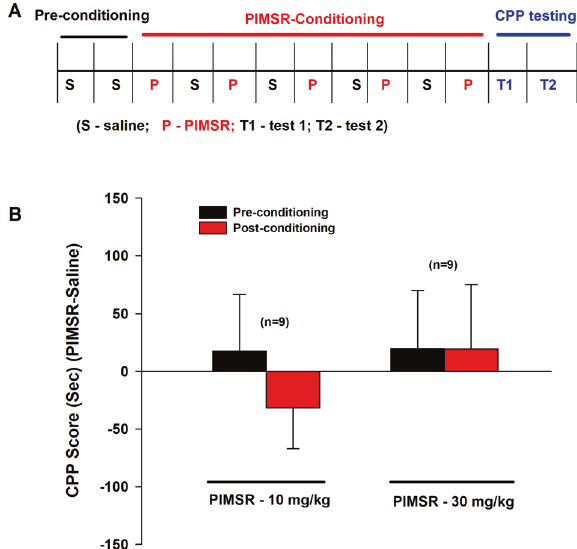
Fig. 4 PIMSR-induced CPP or CPA in mice. A General CPP procedures. B The CPP score (i.e., the averaged value of the two